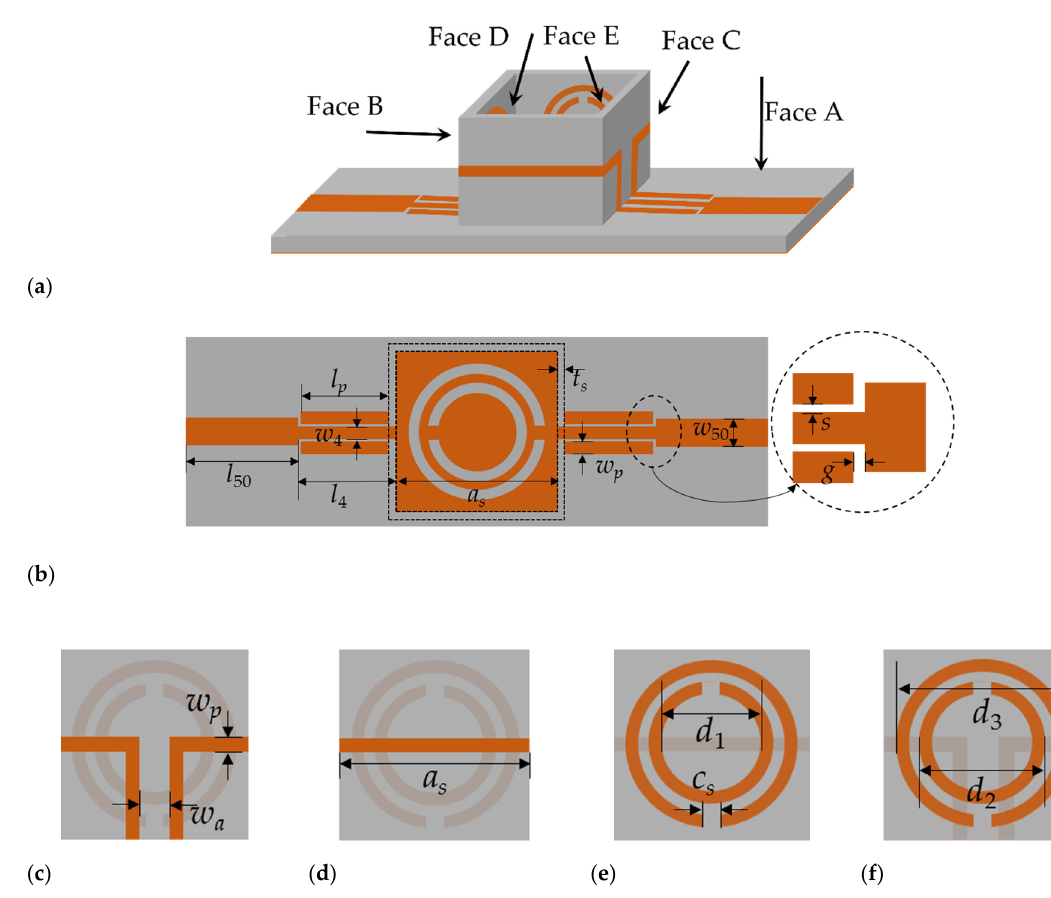
Figure 1. Sensor structure. ( a ) 3-D view; ( b ) Face A; ( c ) Face B; ( d ) Face C; ( e ) Face D; ( f ) Face E. The dimensions are as follows: l 50 = 14.0 mm, w 50 = 2.4 mm, l p = 9.6 mm, w p = 0.8 mm, l 4 = 10.0 mm, w 4 = 1.0mm, a s = 12.3 mm, t s = 0.127 mm, s = 0.1 mm, g = 0.2 mm, h s = 6.5 mm, w a = 12.6 mm, d 1 = 4.0 mm, d 2 = 4.4 mm, d 3 = 5.2 mm, and c s = 1.1 mm.